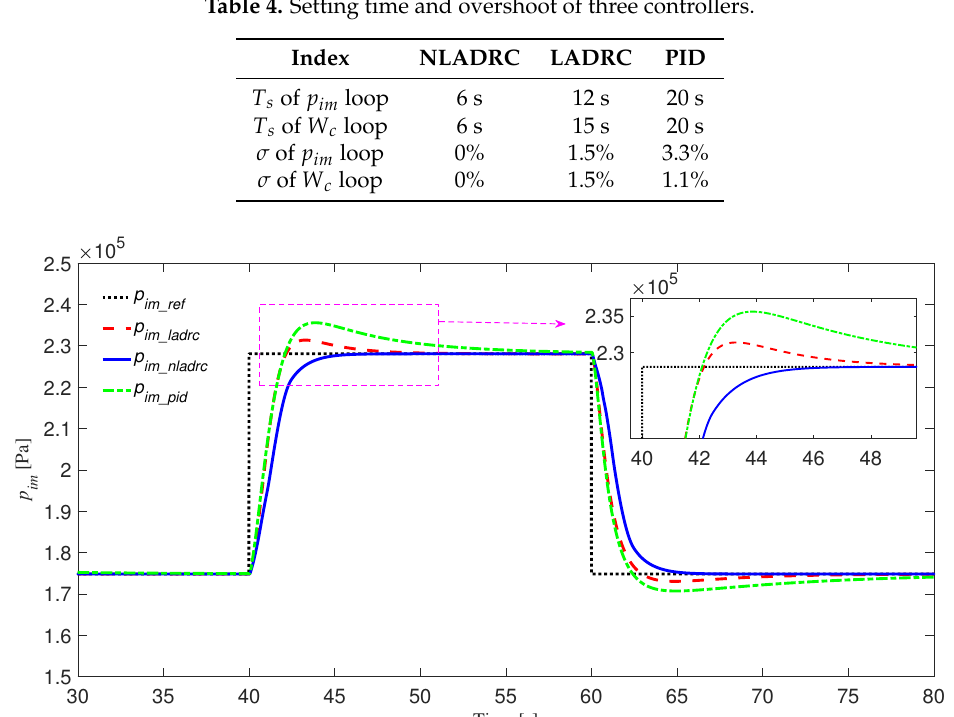
Table 4. Setting time and overshoot of three controllers.